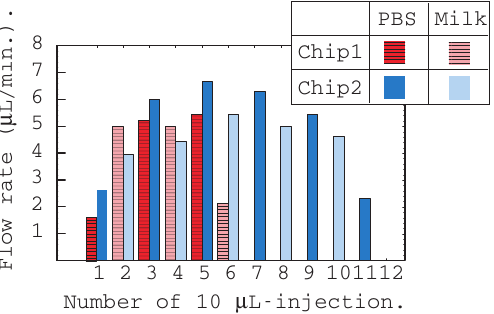
Figure 2. Flow rate distributions of passive fluidic chips calculated from the run-off time of 10 µL injections into the inlet. The run-off time was measured by observing the bottom of the